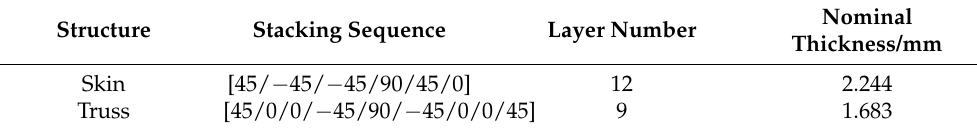
Table 2. Layer information of the specimen.